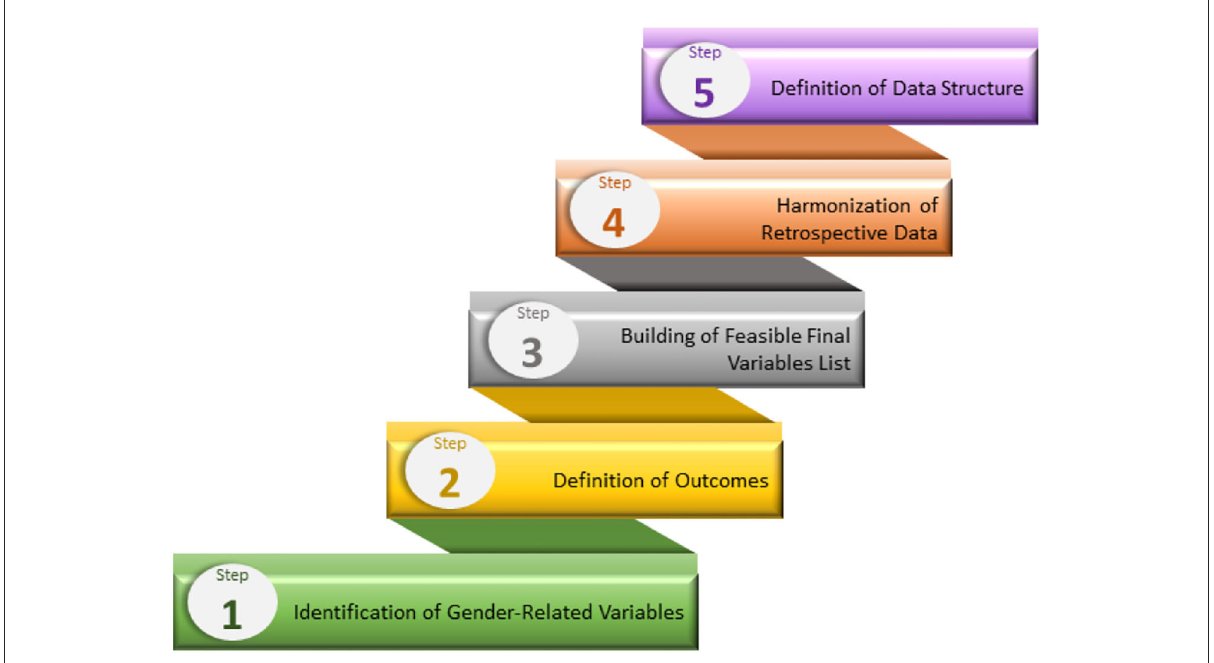
FIGURE3 The GOING-FWD multistep approach for identifying and including gender characteristics in